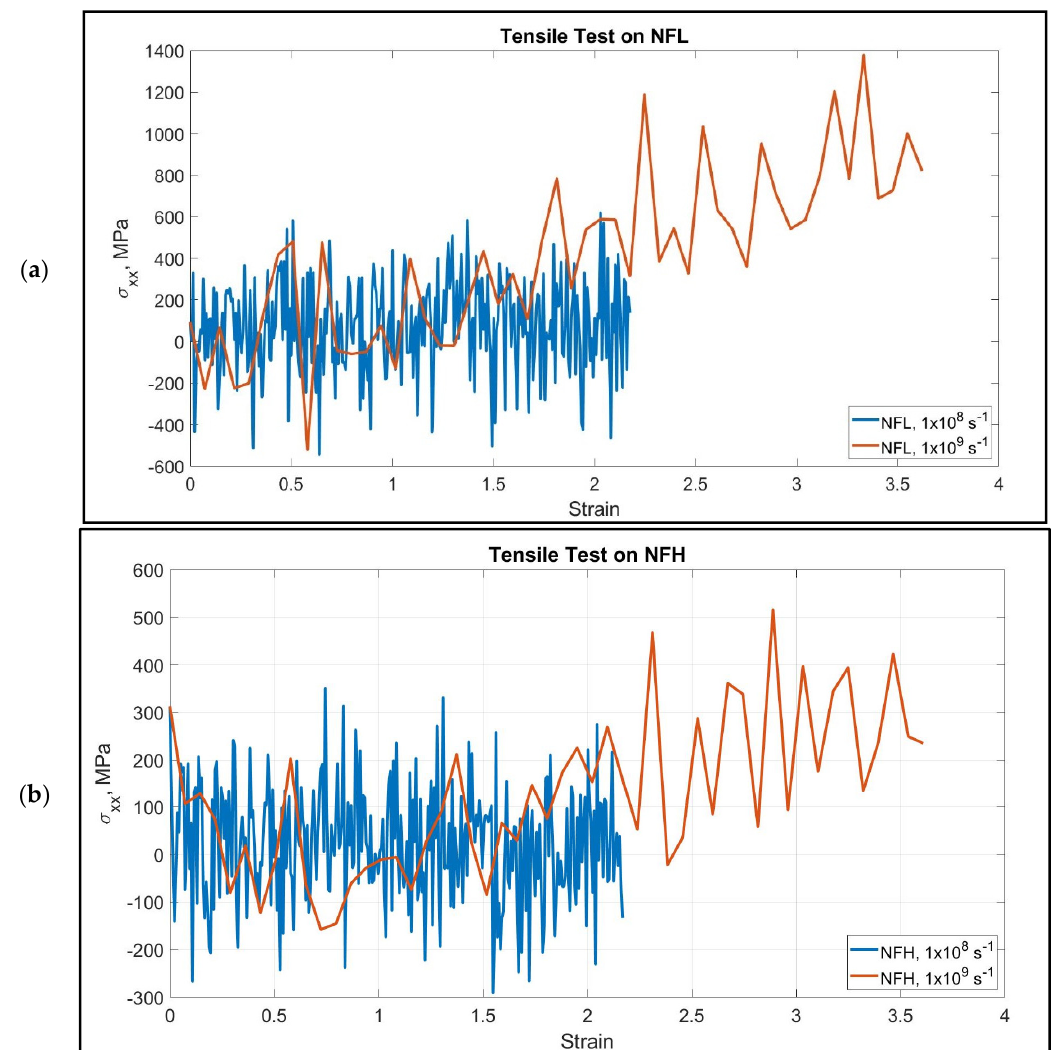
Figure 2. Stress–strain graphs at two different strain rates for the pulled tail domain of ( a ) NFL and ( b ) NFH. Throughout the pulling process, we can observe simultaneous unfolding and stretching, and therefore, these two domains cannot be distinguished. However, NF acts as a stiffer material under the application of higher stress as depicted by the steeper slope at higher strain rate. In order to make a reasonable compromise with the computational cost, we have stopped at ~220% strain for lower strain rate, which we assumed to be sufficient to capture stretched state, while for higher strain rate, we have recorded result till ~360% strain.